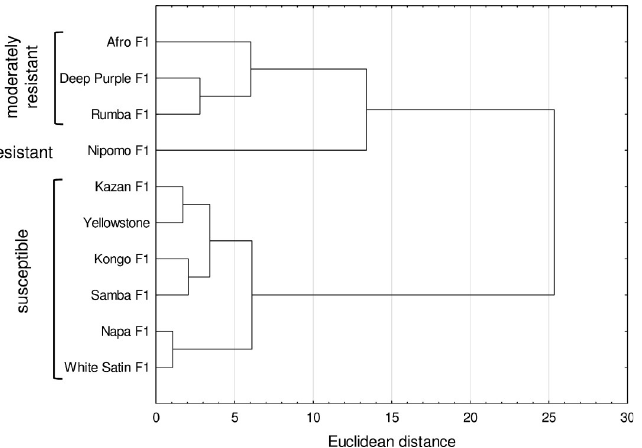
Fig 4. Dendrogram showing the clustering of carrot cultivars based on antibiosis data: Pre-reproductive period ( d ), reproductive period, fecundity of the female ( M generation time ( T ) and net reproduction rate ( R o ).